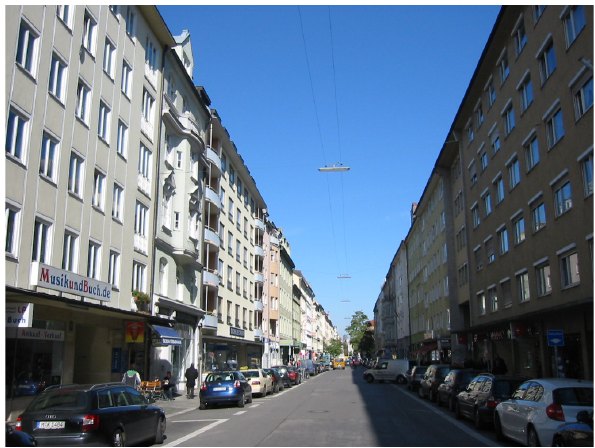
Fig. 2. A typical urban street (Munich): The height of the buildings equals the width of the street.